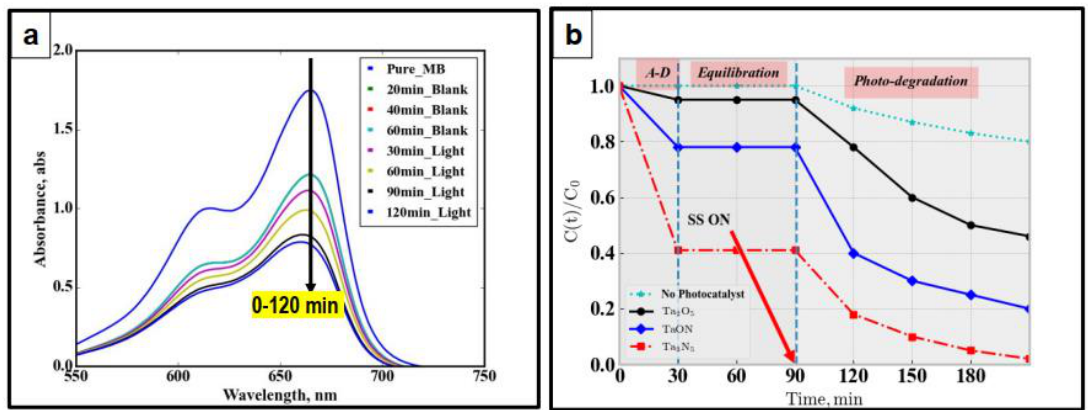
Figure 5. ( a ) A set of representative absorbance spectra of the dye, methylene blue, 28.6 mM MB, in the presence of 0.1 g in-house synthesized Ta 2 O 5 photocatalyst indicating a gradual decrease under Xe lamp solar simulator (SS). ( b ) A comparison of the adsorption, equilibration, and photocatalytic conversion of MB in the presence of 0.1 g Ta 2 O 5 , TaON, and Ta 3 N 5 each is presented.